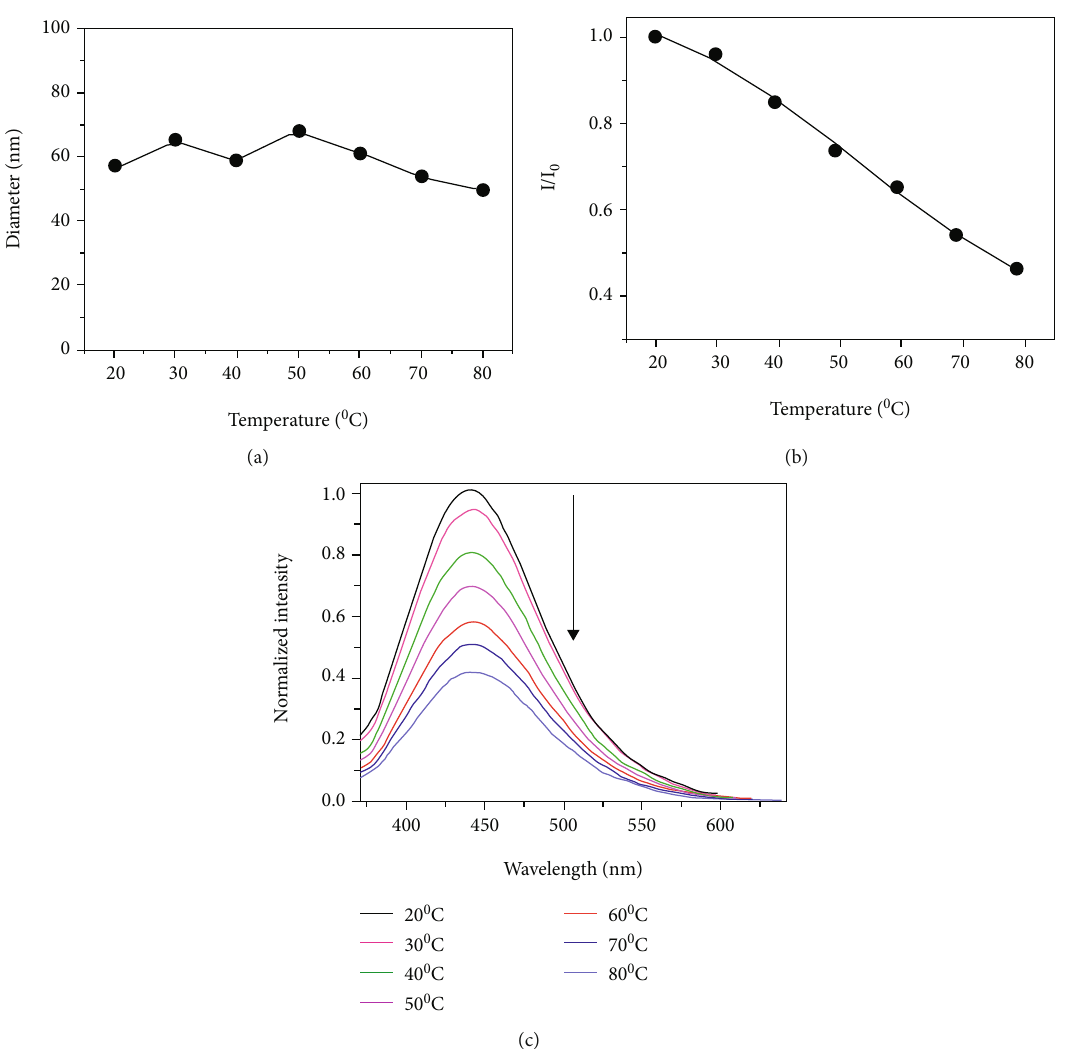
Figure 4: Temperature dependence of (a) average hydrodynamic diameters and (b) normalized scattering light intensity record for micelles in aqueous solution at pH = 8 . (c) Normalized fl uorescence spectra of PIC micelles in aqueous composed by WCS and TPE-(N-COOH) 4 solution versus temperature at pH = 8 , λ ex = 345 nm. The [NH 3+ ]/[COO - ] molar ratio was